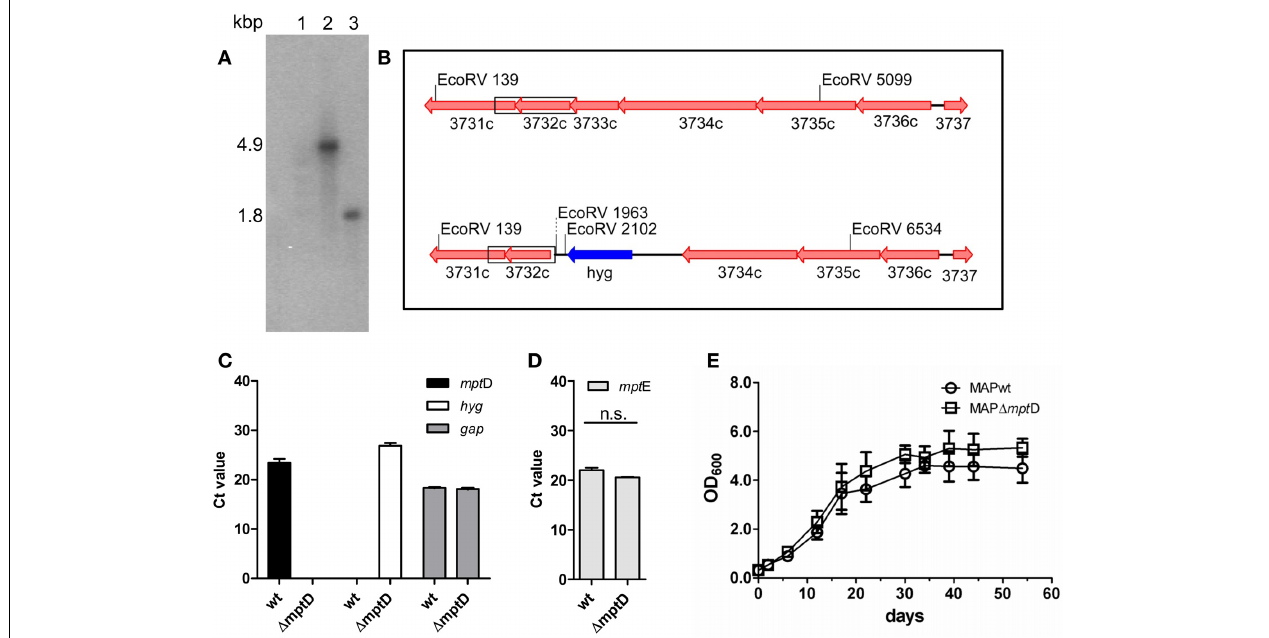
FIGURE 1 | Confirmation and characterization of MAP (cid:2) mpt D mutant by Southern blot analysis (A,B), qRT-PCR (C,D) and growth experiments (E). (A) EcoRV restricted genomic DNA of MAPwt (lane 2) and MAP (cid:2) mpt D mutant strain (lane 3), Southern blotted and hybridized with a probe against mpt E (MAP3732c). In the wild type a 4.9kbp fragment is labeled, the mutant strain shows a 1.8kbp fragment. Lane 1 DNA marker. (B) Genomic sketch of the mpt region spanning genes mpt F (MAP3731c) to mpt A (MAP3736c) in MAPwt (top) and (cid:2) mpt D mutant strains (bottom). Position of EcoRV restriction sites are indicated, the α 32 -P-dCTP labeled probe fragment is boxed.